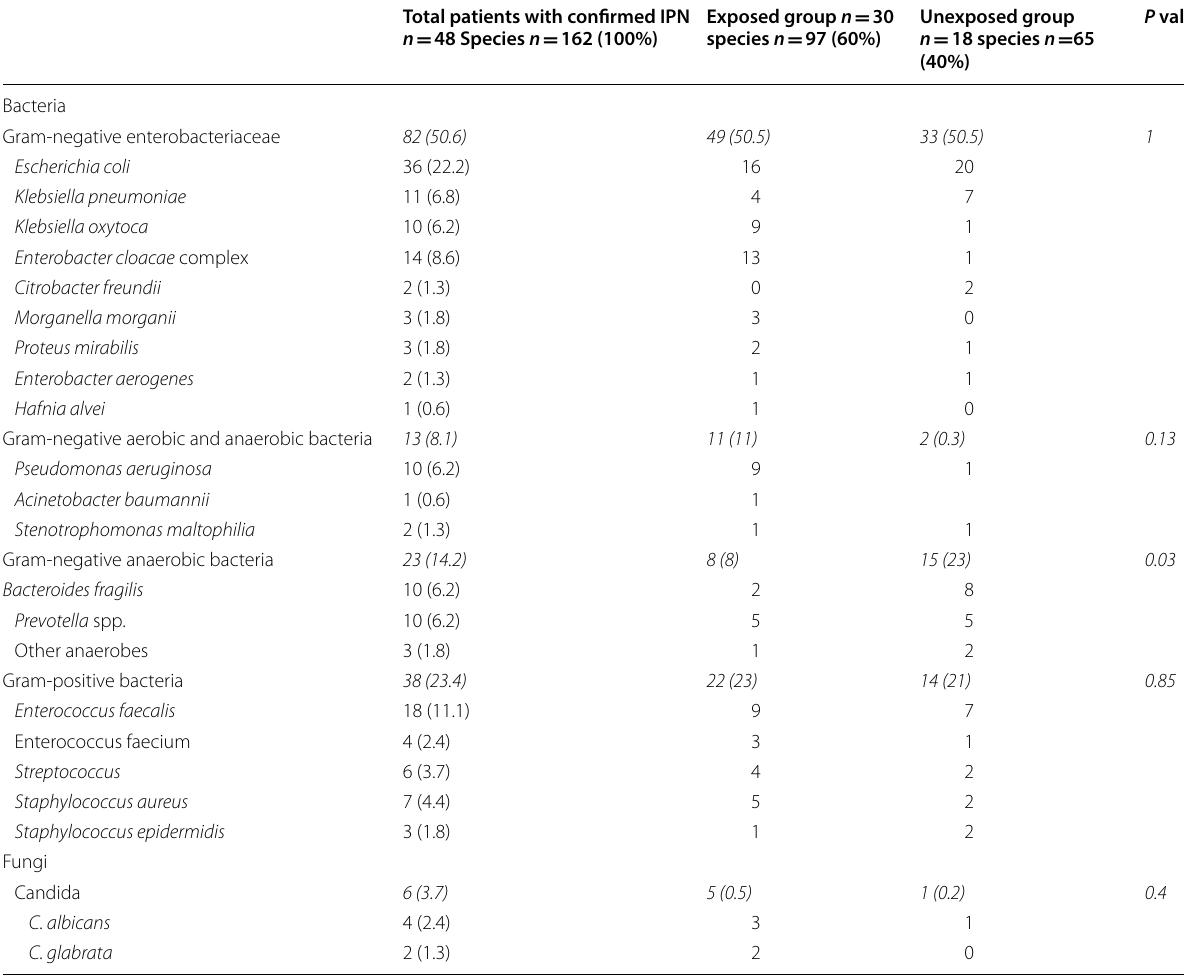
Table 3 Distribution of microorganisms recovered at the time of the first sampling in 107 positive samples in the groups exposed and unexposed to